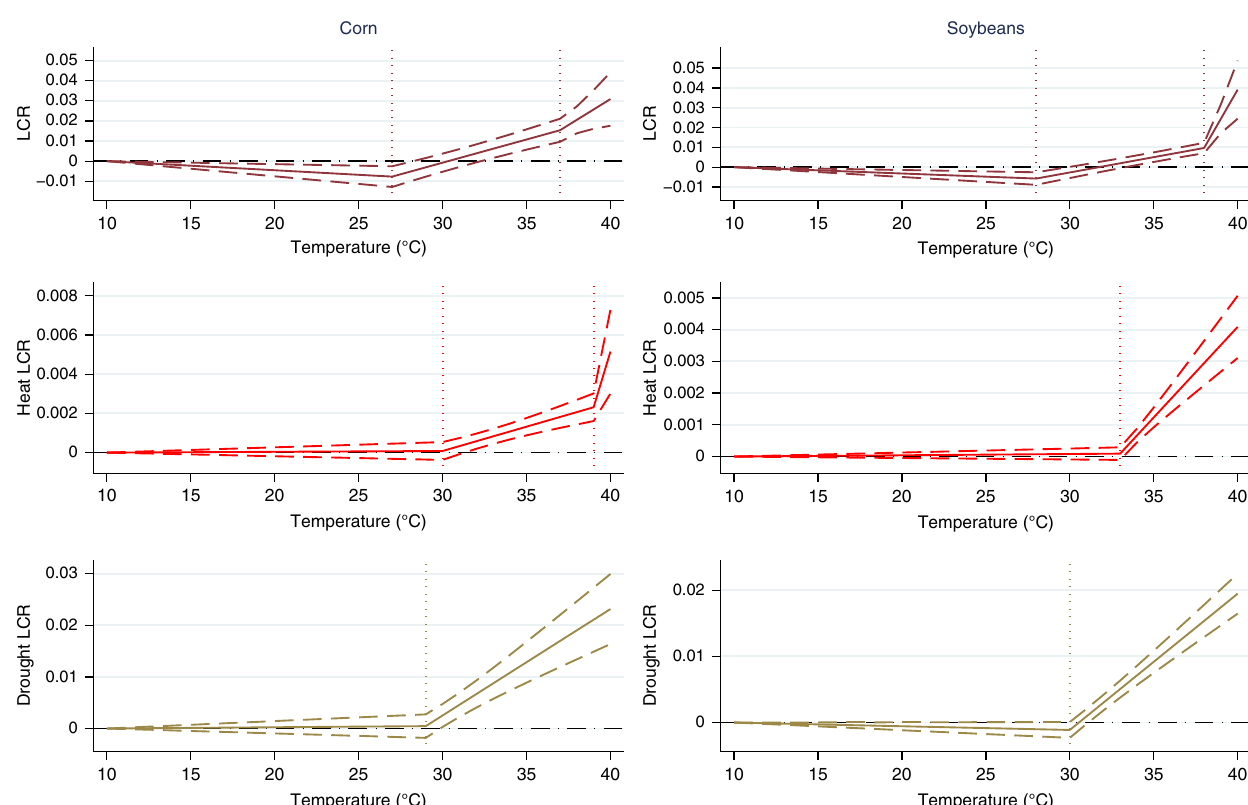
Fig. 3 Marginal effects of temperature on the heat and drought LCRs ( N = 30,261 for corn and N = 29,014 for soybeans). Dashed lines represent 95% con fi dence intervals and standard errors are clustered by year. For the drought LCRs and soybean heat LCR, the second cutoffs exceed 40 °C and the marginal effects in the last temperature intervals are too large to be